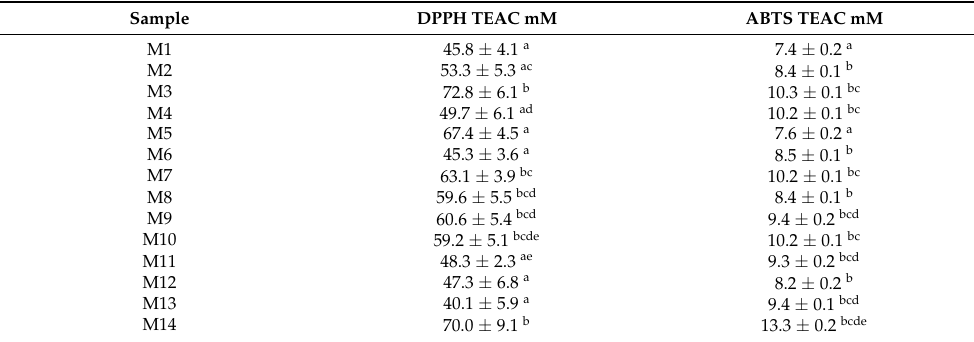
Table 4. Antioxidant activities of pomegranate peels M1-M14. Different letters within each col- umn indicate statistically significant differences at p ≤ 0.05 in an ANOVA and Tukey’s pairwise t -test analysis.